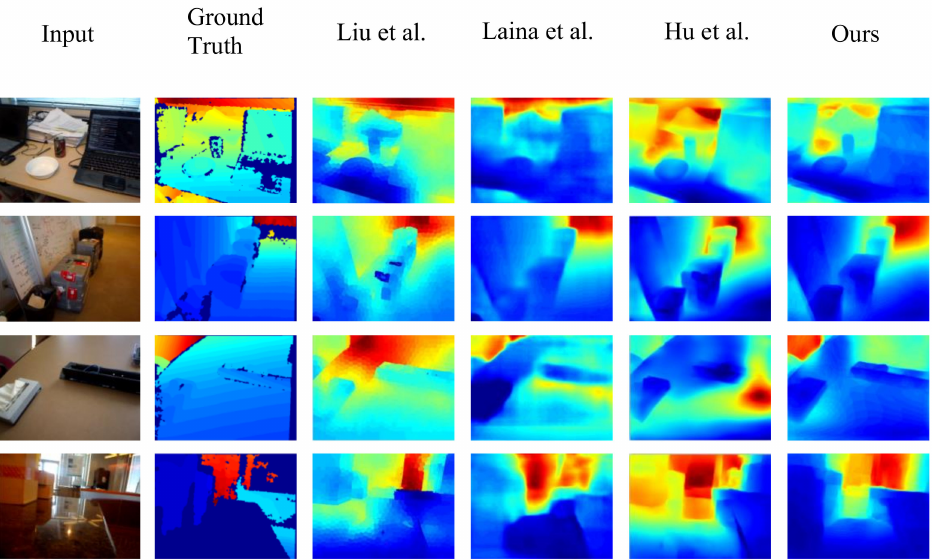
Figure 10. Visual comparison on the scene dataset V1. The first column to last column: input, ground truth, depths recovered by Liu et al. [21], Laina et al. [5], Hu et al. [6], and our method. Table 8. Quantitative evaluation for the scene dataset V1 with the NYU Depth V2 model. Methods